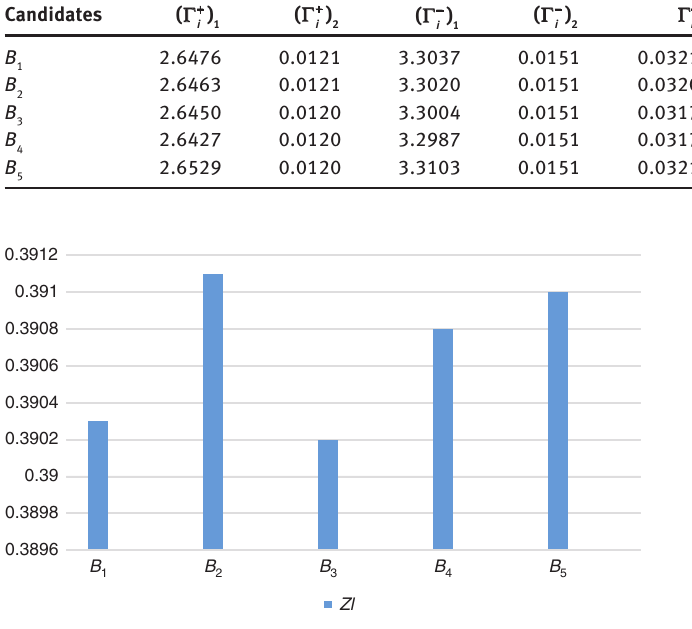
Figure 5: Comparison Between Preference Order Ranking of the Cubic Fuzzy Technique for Order Performance by Similarity to Ideal Solution TOPSIS and the Proposed Cubic Fuzzy Model.